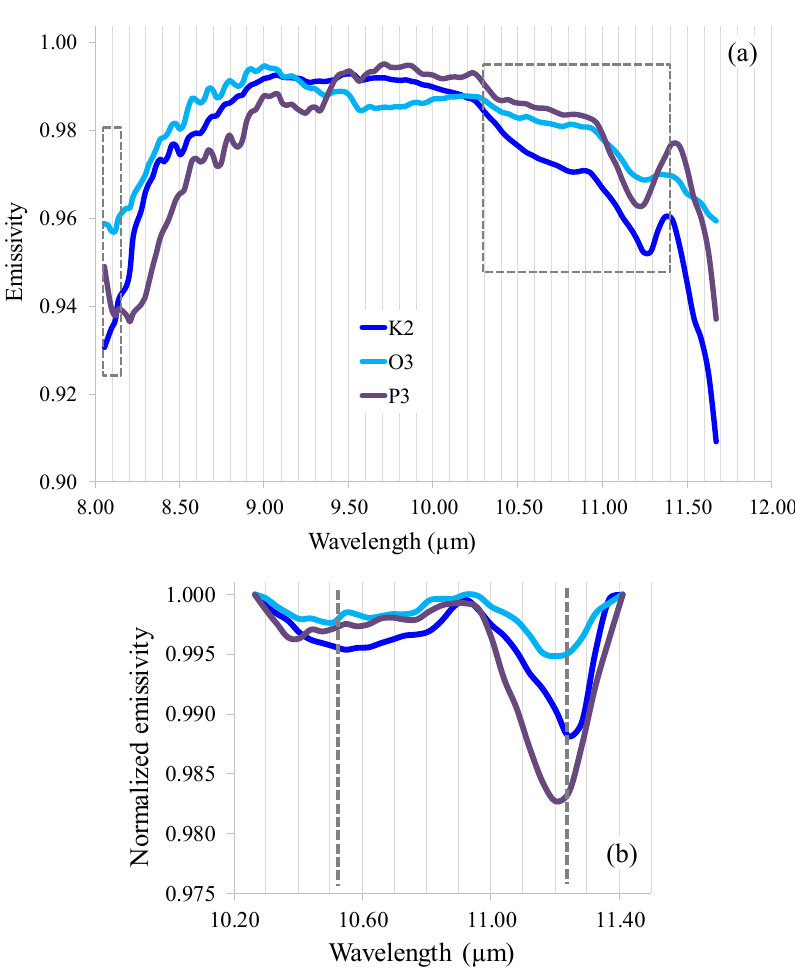
Figure 3. ( a ) Emissivity spectra of selected soil samples; gray dashed boxes emphasize indicative absorption features of carbonates. Each spectrum is the average of tens of pixels in the calculated emissivity image. ( b ) Normalized emissivity spectra; gray dashed lines emphasize the wavelengths mentioned in the text.